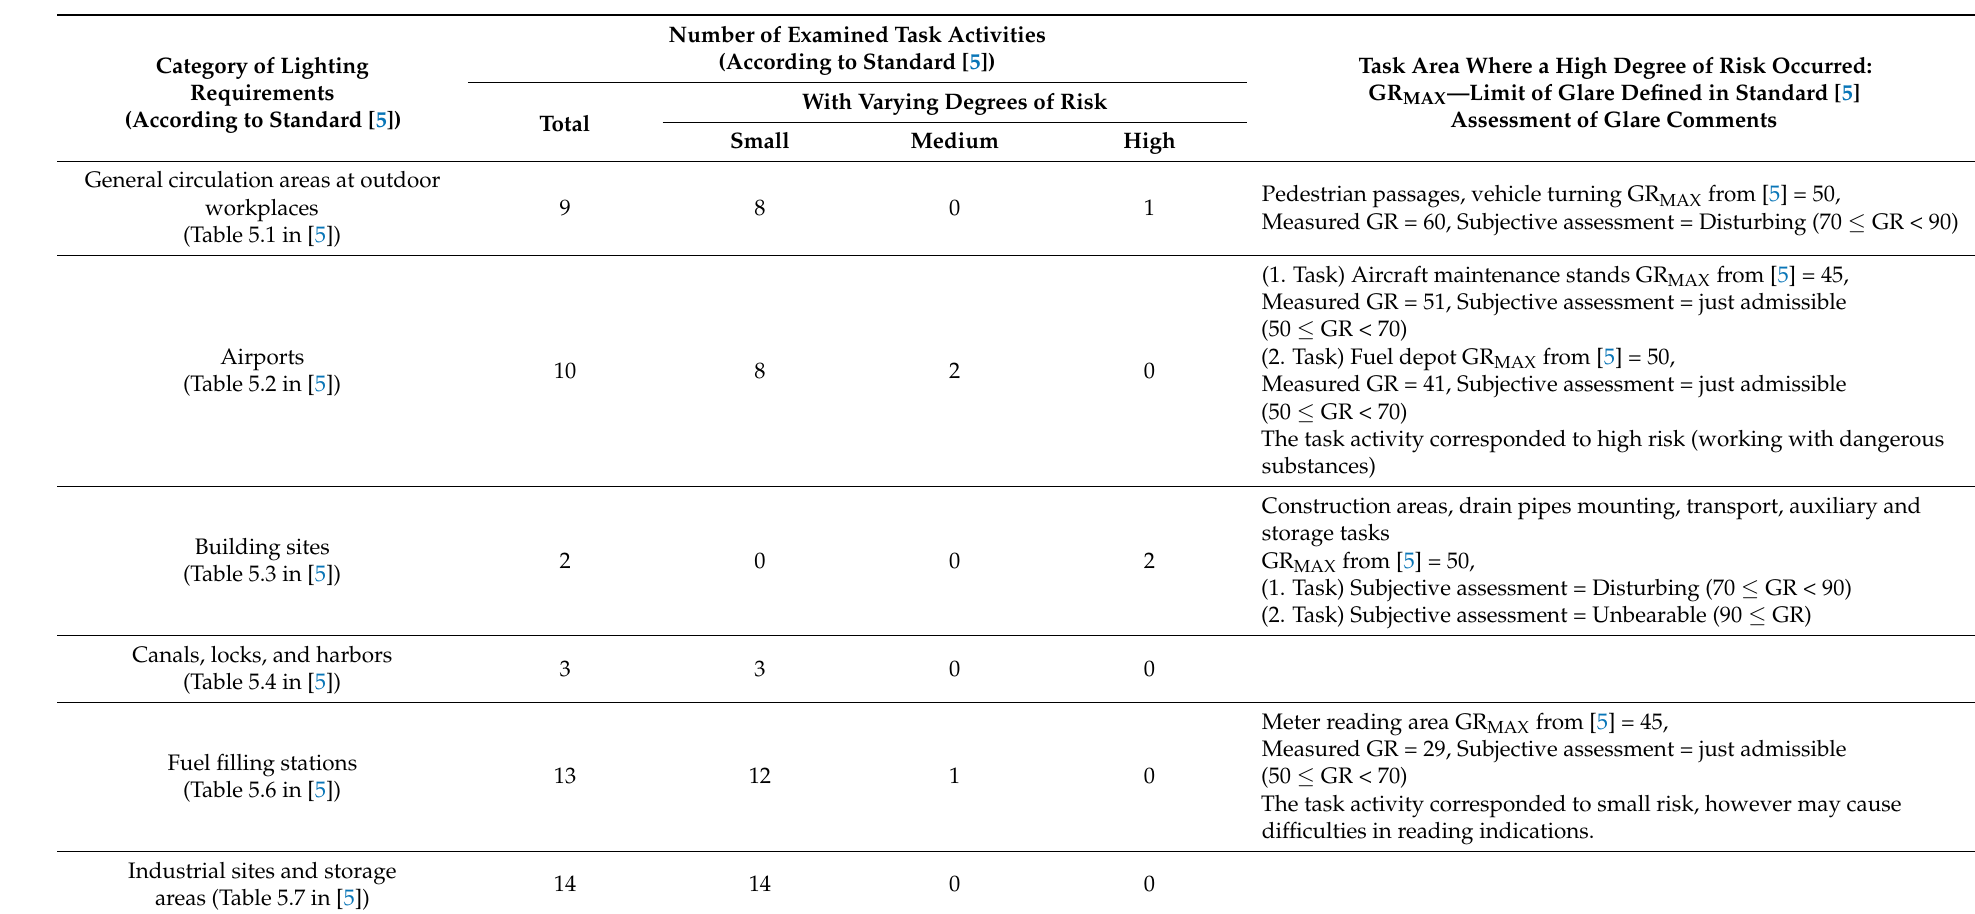
Table 4. Summary table of results arranged according to the hazard